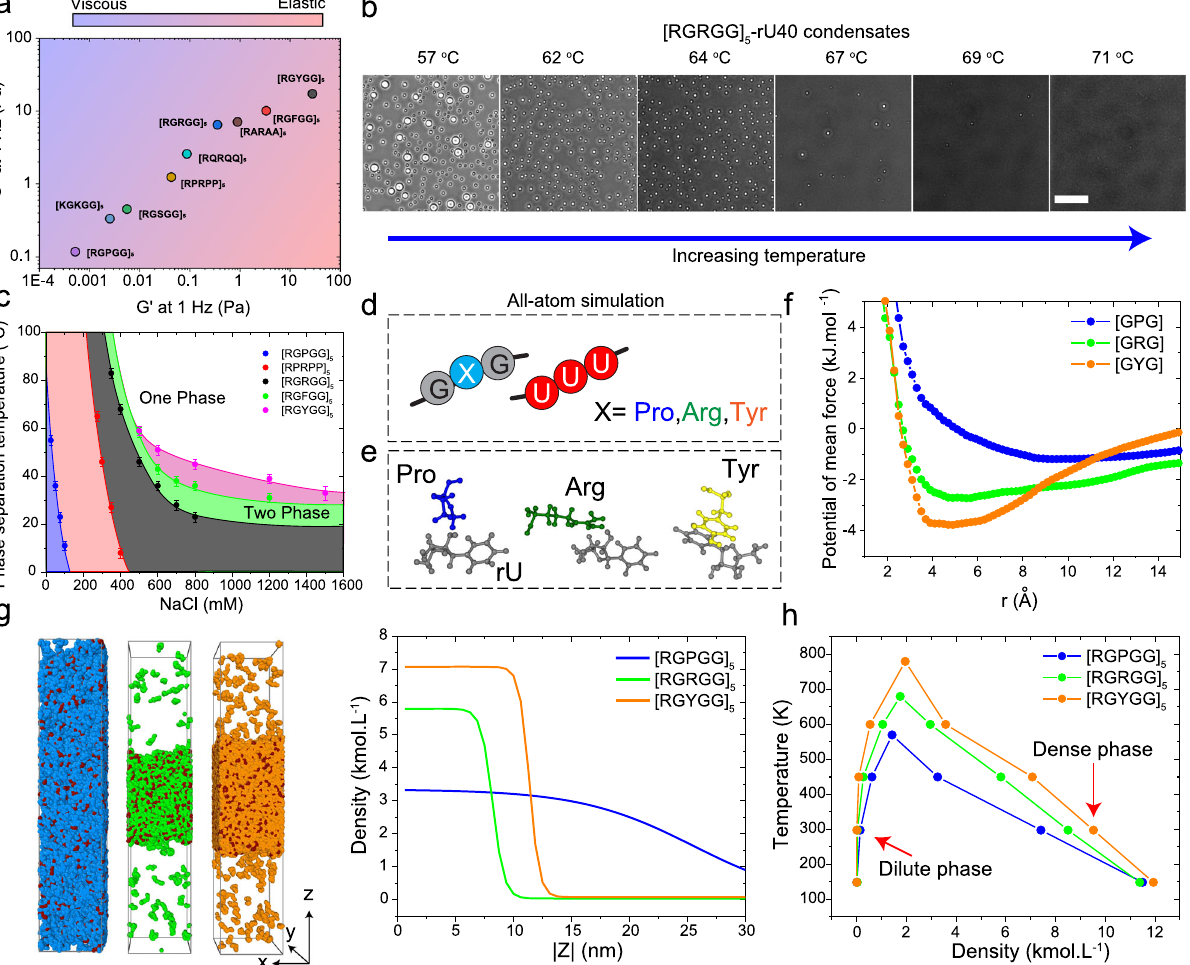
Fig. 4 Peptide-RNA interactions govern the condensate LVE properties. a A material state diagram showing the elastic (G ’ ) and viscous (G ” ) moduli at 1 Hz frequency for the various condensates tested in this study. This plot shows a broad range of tunability in condensate viscoelasticity via sequence perturbations. b Bright- fi eld images of [RGRGG] 5 -rU40 condensates showing phase separation upon cooling. Scale bar is 20 µ m. c Temperature-salt state diagram for [RGPGG] 5 , [RPRPP] 5 , [RGRGG] 5 , [RGFGG] 5 , and [RGYGG] 5 mixtures with rU40 RNA. Shaded regions indicate the salt and temperature conditions that allow phase separation. The most stable peptide-RNA condensates are [RGYGG] 5 -rU40 and the least stable are [RGPGG] 5 -rU40 condensates. Error bars represent the temperature range between a phase separated sample and a homogeneous (not phase separated) sample. d A scheme summarizing the all-atom simulations of tri-amino acids [GXG] and a tri-nucleotide [rUrUrU] where X was set to either Arg or Pro or Tyr. e All- atom simulation equilibrium snapshots of Pro-rU, Arg-rU, and Tyr-rU interactions. Note the π - π stacking in the case of Tyr-rU pair that leads to stronger interactions with RNA. f Free energy pro fi les of [GXG]-[rUrUrU] attraction from model peptide-RNA all-atom constant temperature simulations shown in e . X is set to Arg, Pro, or Tyr. The tripeptide that is stickiest to [rUrUrU] is [GYG] while [GPG] has the weakest interaction with the trinucleotide. g Snapshots from the coexistence simulations with coarse grained molecular models of full peptide sequences and rU40 RNA showing the equilibrium con fi guration of peptide and RNA chains in [RGPGG] 5 -rU40, [RGRGG] 5 -rU40, and [RGYGG] 5 -rU40 mixtures at a temperature of 450 K. The rU units are colored in red. The Pro units are colored in blue. The Arg units are colored in green. The Tyr units are colored in orange. Corresponding density pro fi les are shown along the z-direction of the box. h Temperature-density phase diagrams for [RGPGG] 5 -rU40, [RGRGG] 5 -rU40, and [RGYGG] 5 -rU40 condensates as extracted from the coexistence simulations in g . At each temperature, the densities of the condensed and dilute phases are